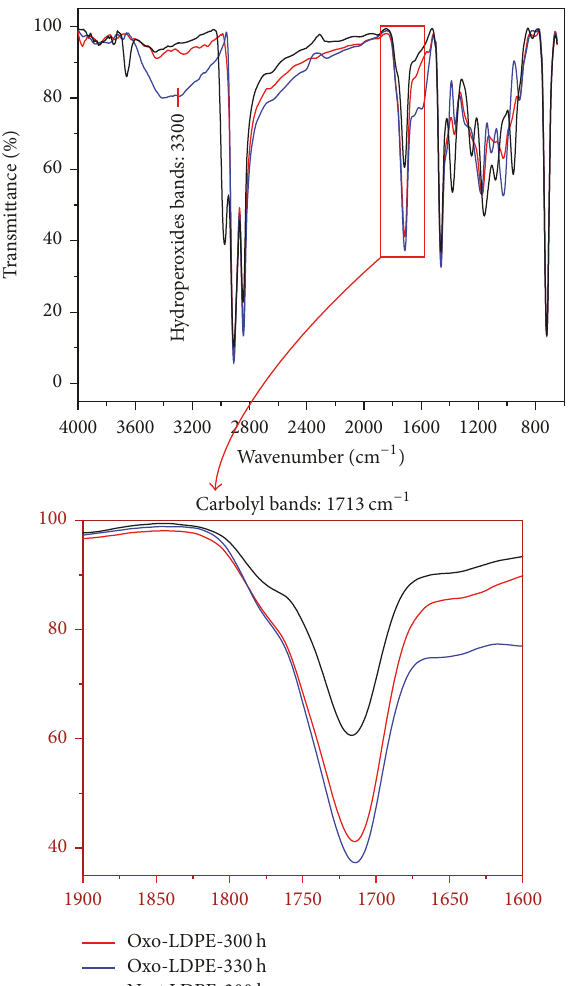
Figure 4: Carbonyl and hydroperoxides bands evolution in time of exposure in a Xenon arc chamber for oxo-degradable LDPE films studied by